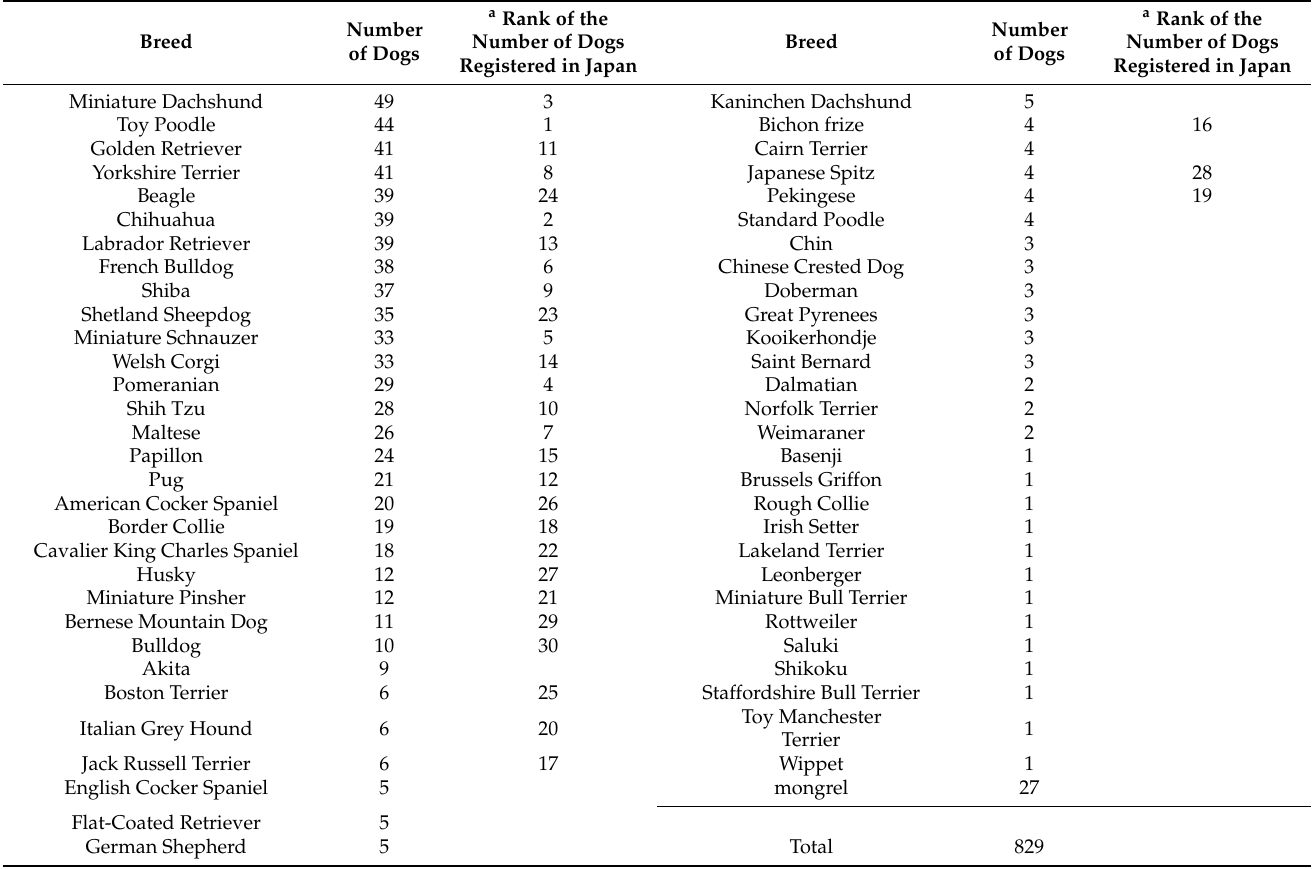
Table 1. Number of dogs in each of the 59 breeds and mongrels analyzed in this study.